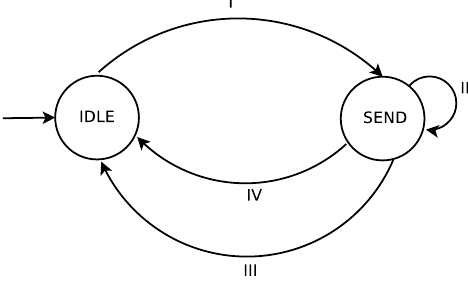
Figure 2. Finite State Machine for the Server/Responder. Table 2. Description of the Server